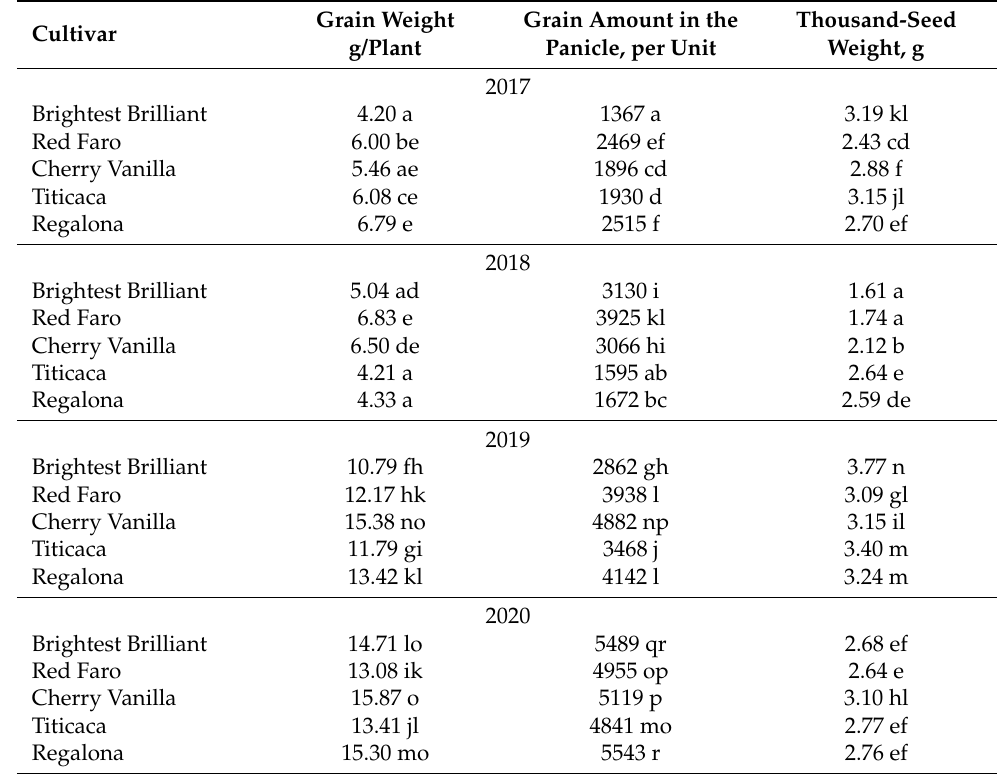
Table 5. Quinoa yield